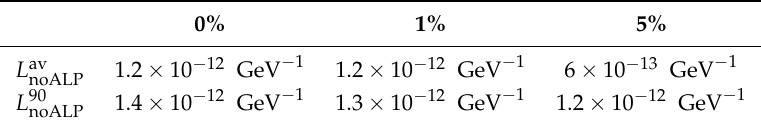
Table 1. Projected upper limits on g a γγ with IXPE. The columns correspond to different intrinsic polarisations of the AGN. The rows correspond to whether the average or 90th percentile likelihood value is used to characterize how well the no ALP model fits the simulated data.